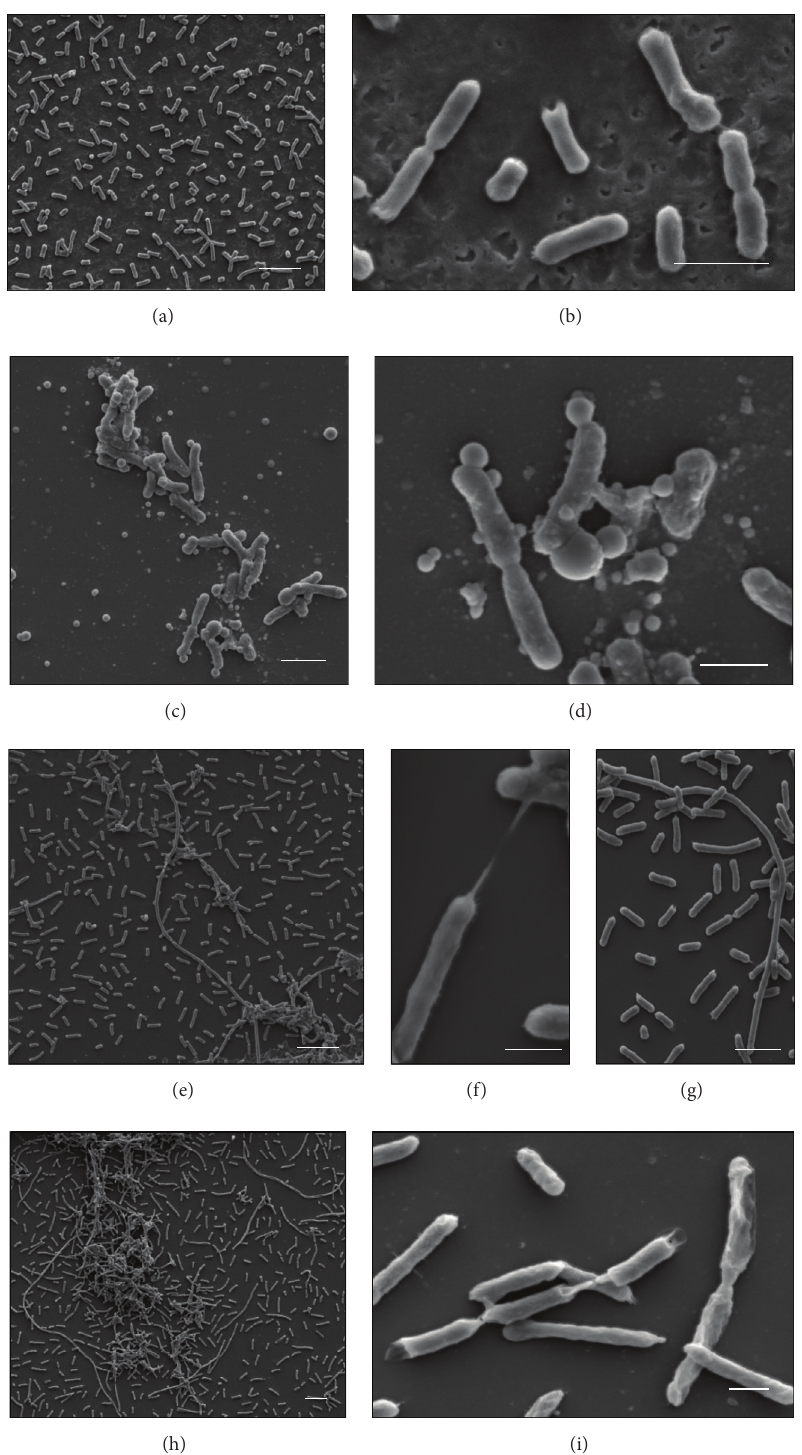
Figure 4: (a–i) Scanning electron micrographs of isolate K652. (a-b) Control cells with preserved morphology. (c-d) Cells subjected to CTX (98 𝜇 gmL −1 ). Observe spherical cells that are not grown being formed from cells with preserved morphology. (e–g) Cells subjected to CAZ (27 𝜇 gmL −1 ). Observe elongated cells forming bacterial filaments. (h-i) Cells subjected to IMP (16 𝜇 gmL −1 ). Observe elongated cells due to unfinished successive divisions. Bars = 2 𝜇 m. CAZ: ceftazidime; CTX: cefotaxime; and IMP: